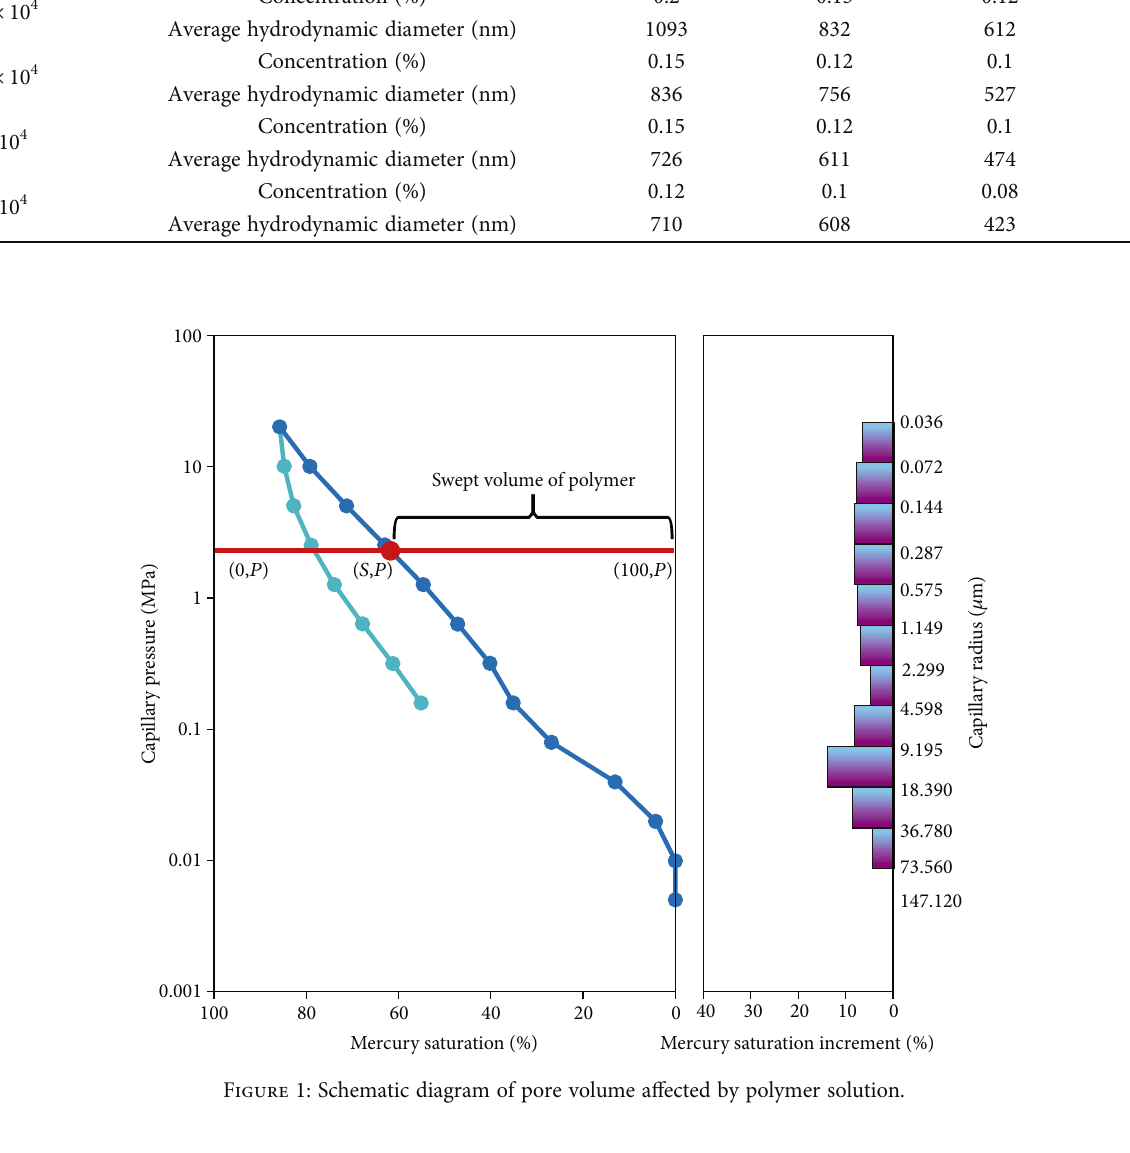
Table 4: Average hydrodynamic diameter test results of polymer solutions with di ff erent molecular weights/concentrations. 1500 × 10